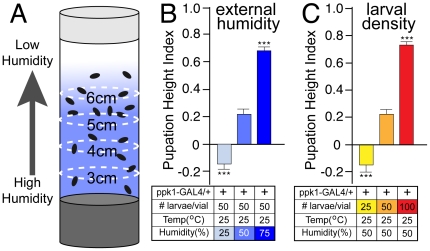
Control of pupation height behavior by the internal microenvironment of the culture vial.(A) Schematic representation of a Drosophila culture vial and the internal humidity gradient generated within the microenvironment of the plugged vial. Higher humidity at the bottom near the food surface is indicated as darker shading decreasing to low humidity at the top of the vial. Pupae are shown as black ovals within the designated zones indicated as height(cm) above the vial bottom used to calculate the pupation height index(PHI). PHI = ((#pupae>3 cm)-(#pupae<3 cm))/total # pupae. (BC) Pupation height behavior for ppk1-GAL4/+ control larvae represented by the indicated Pupation Height Index; (B) Pupation height is strongly influenced by external humidity. With constant larval density(50 larvae/vial), low external humidity(25%) causes larvae to pupate at sites lower in the vial indicated as a downward deflection. At higher humidity(50% and 75%), larvae choose to predominantly pupate at higher sites within the vial indicated as an upward deflection. (C) Pupation height is influenced by larval density. With vials grown at constant external humidity(50%), low larval density(25 larvae/vial) causes a low pupation height. Higher larval density causes a drastic increase in pupation height resulting from the altered microenvironment as larvae exit the food source. Error bars represent SEM with n≥15 for all values. ***P<.0001, one-way ANOVA with Tukey posttest.